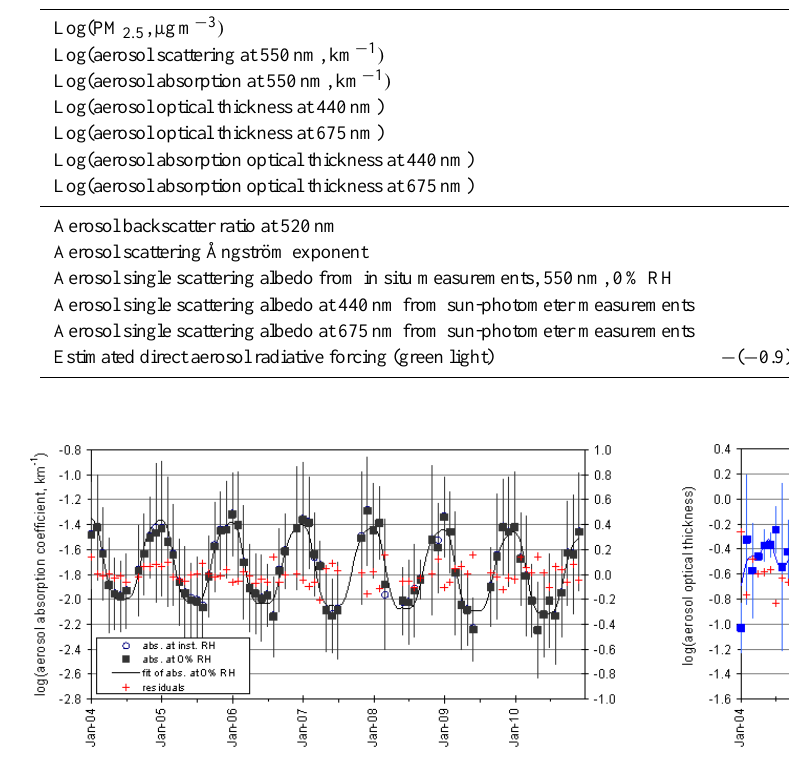
Figure 4. Variations in the aerosol optical thickness at 440nm at IPR: logarithm of the monthly mean values (squares), least mean square fit of the logarithm of the monthly mean values, and residuals (crosses, right axis). Error bars show the standard deviation of the log of the monthly